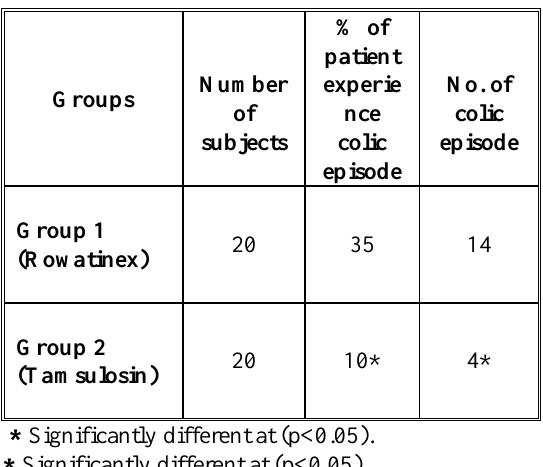
Table 3: The effects of rowatinex and tamsulosin on the incidence of colic episodes in patients with ureteric stone.